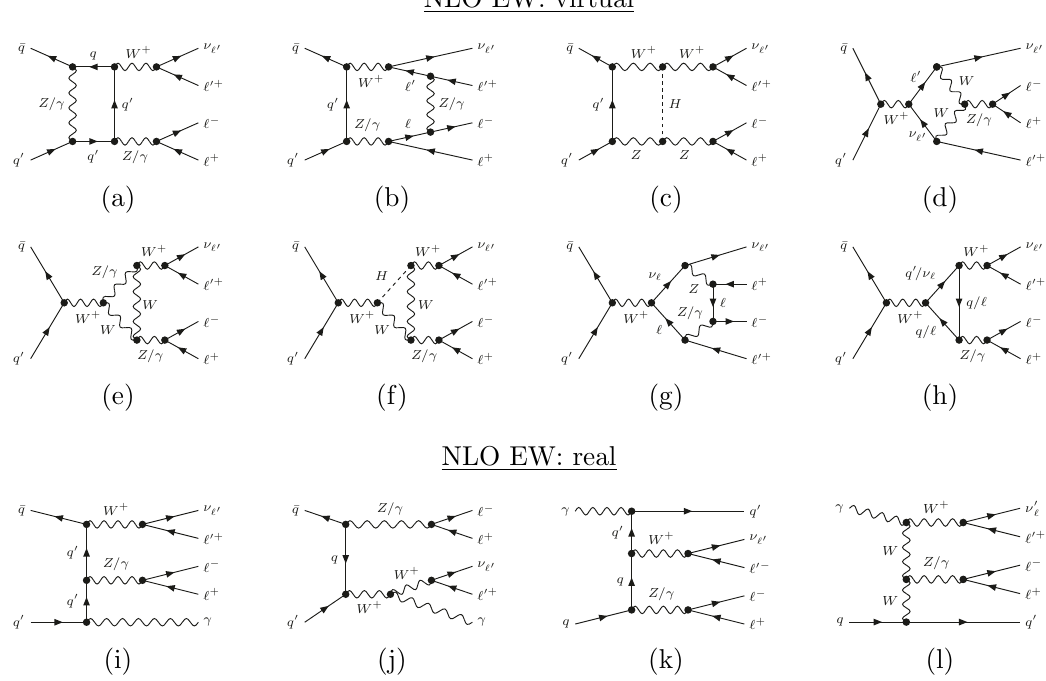
+ Z ) (cid:0) ‘ 0 (cid:23) ‘ 0 ( W